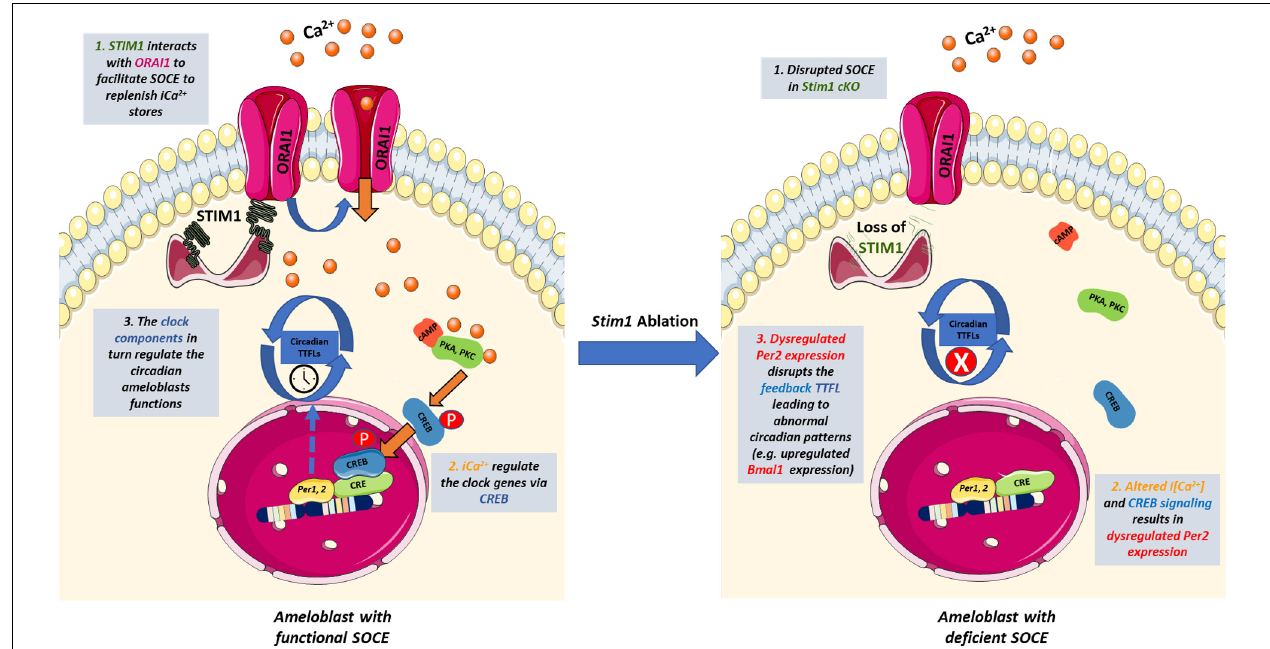
FIGURE 4 | The potential cross-talk between SOCE and the circadian clock in ameloblasts. Schematic representation summarizing how SOCE can potentially influence the ameloblasts’ circadian clock based on our findings. Upon Ca 2 + depletion in the ER, STIM1 binds to ORAI to facilitate Ca 2 + entry and activate Ca 2 + -dependent signal transduction. Calcium induces the activity of Ca 2 + /calmodulin-dependent protein kinases which activate PKA and PKC that phosphorylate CREB in a circadian manner. The phosphorylated CREB translocate to the nucleus where it recognizes the cAMP Response Element in the promoter region of Per1 & 2 and serves as a transcription factor. PER1 & 2 are core regulators of the mammalian circadian clock and participate in forming the autoregulatory TTFL. Disruption of SOCE in Stim1 cKO ameloblasts resulted in dysregulated expression of Per2 that disrupts the TTFLs leading to abnormal circadian patterns including an upregulated Bmal1 expression that maybe involved in the development of SOCE mediated AI. iCa 2 + , intracellular calcium; TTFL, transcription translation feedback loop; PKA, protein Kinase A; PKC, protein Kinase C; CREB, cAMP response element-binding protein; STIM1, Stromal interaction molecule 1; P, Phosphate group. This figure was created with images adapted from Servier Medical Art by Servier. Original images are licensed under a Creative Commons Attribution 3.0 Unported License.